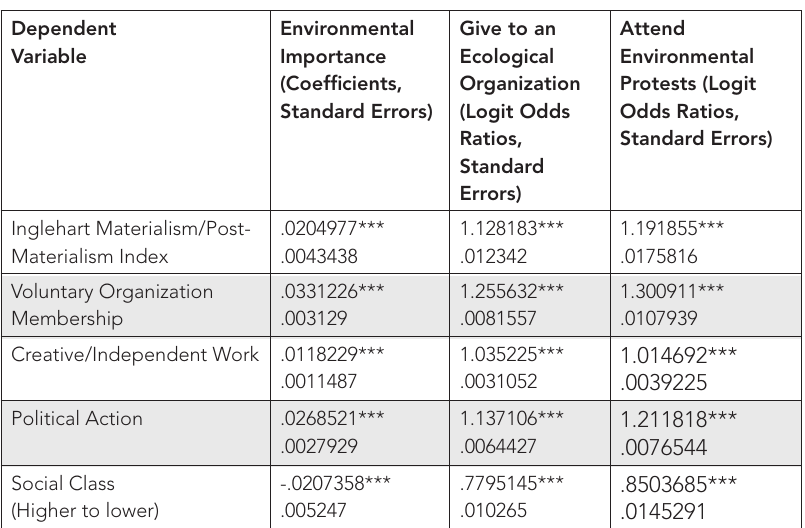
Table 6: Mixed Effects Environmental Support